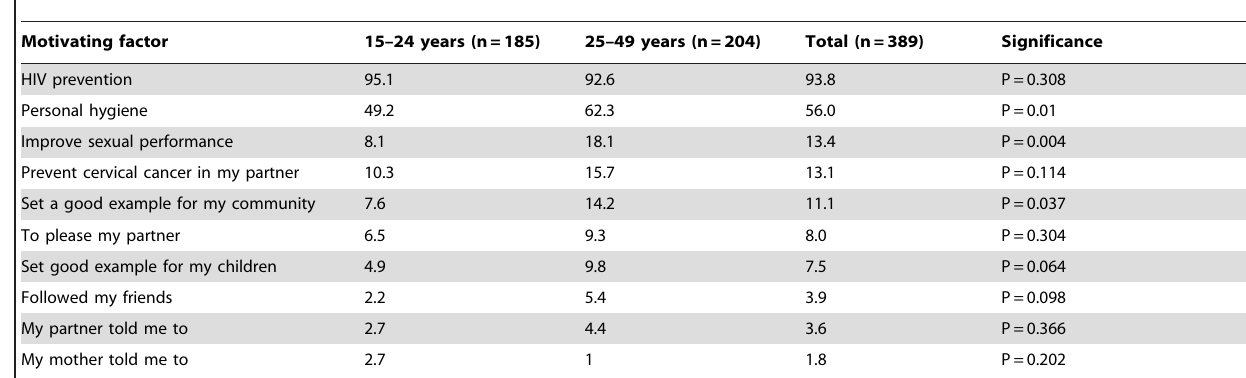
Table 4. Motivating factors for VMMC by age among males 15–49 year olds willing to be circumcised.